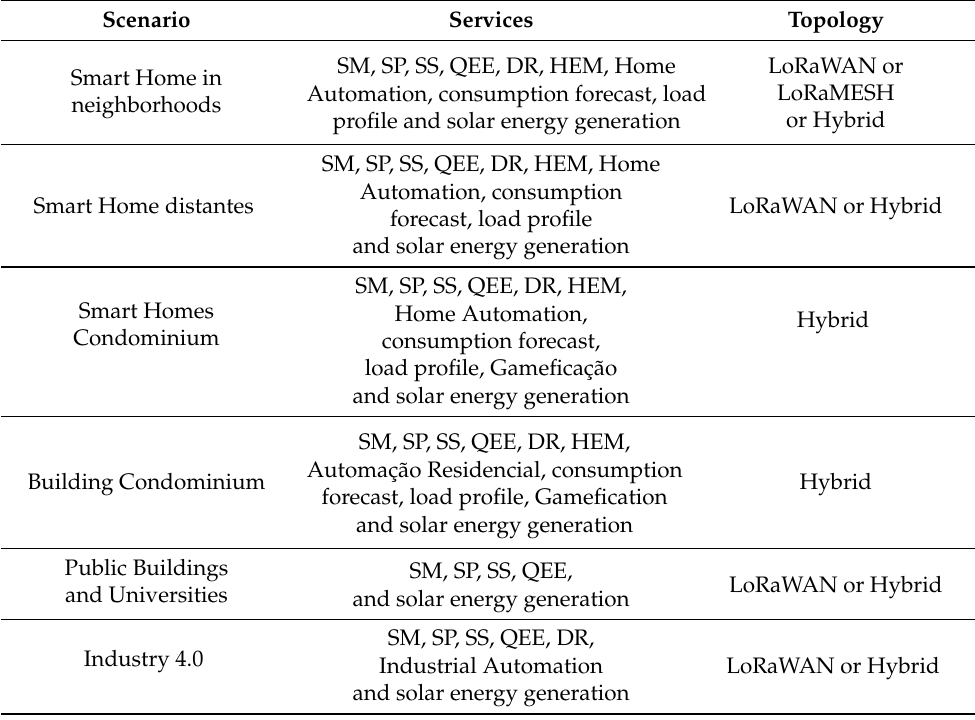
Table 7. Scenarios and services to be used by